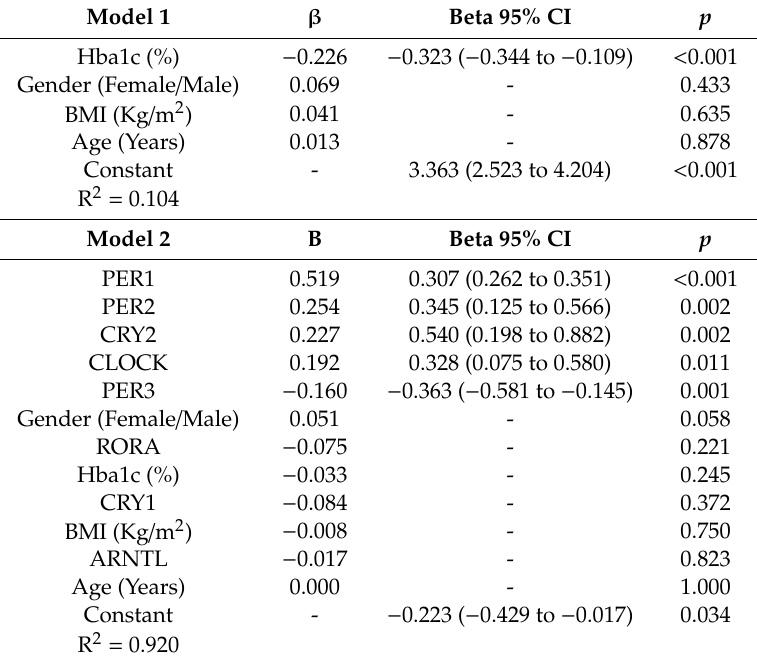
Table 3. Variables independently related to HIF-1 α gene expression in the multiple regression analysis (stepwise method) without (model 1) or with (model 2) the inclusion of clock genes as independent